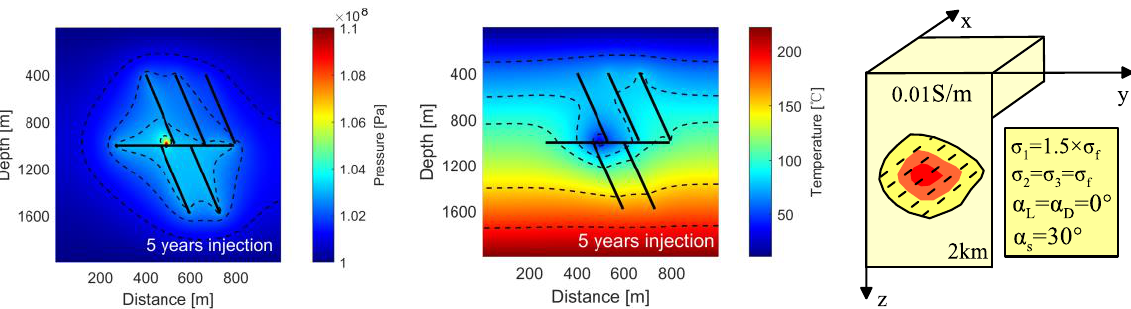
Figure 14. Coupled field model of temperature, pressure, and conductivity after 5 years of injection.